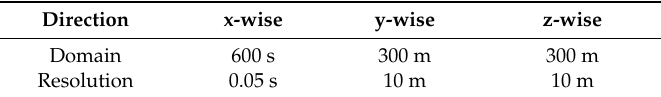
Table 2. Wind model domain and resolution.